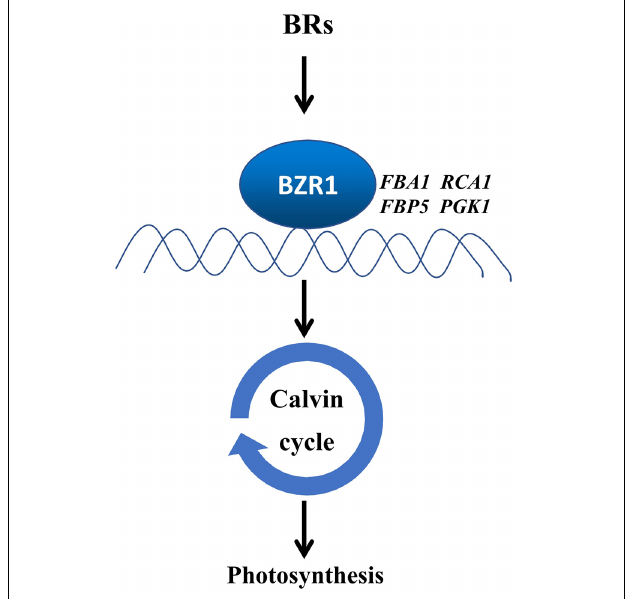
FIGURE 7 | A proposed model for the induction of photosynthesis by BRs in a BZR1-dependent way. BZR1 regulates photosynthesis through the activation of the Calvin cycle in tomatoes. BRs induced the accumulation of BZR1 protein, especially the dephosphorylated forms of BZR1, which activates the transcription of the Calvin cycle genes such as FBA1, RCA1, FBP5, and PGK1 by directly binding to their promoters, subsequently enhancing the Calvin cycle. The induction of the Calvin cycle promotes photosynthesis. Arrows denote positive